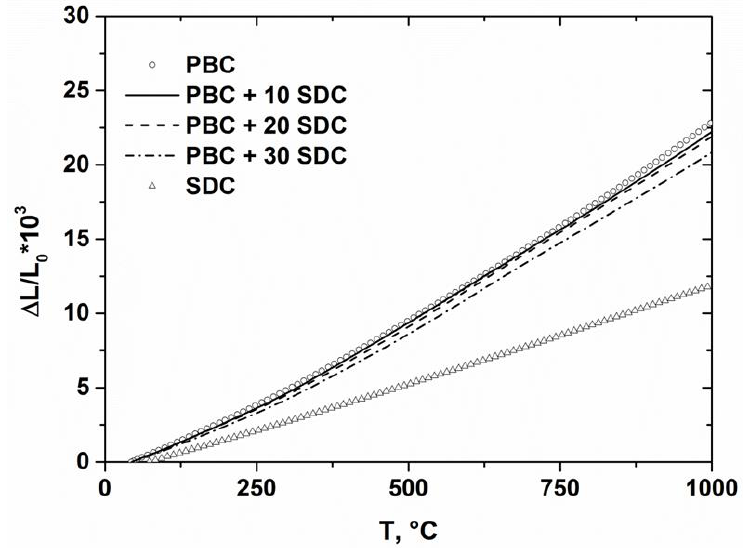
Figure 6. Thermal expansion of (100 − y )PBC- y SDC ( y = 0–30 wt.%) cathode materials and Ce 0.8 Sm 0.2 O 1.9 electrolyte in air [45].